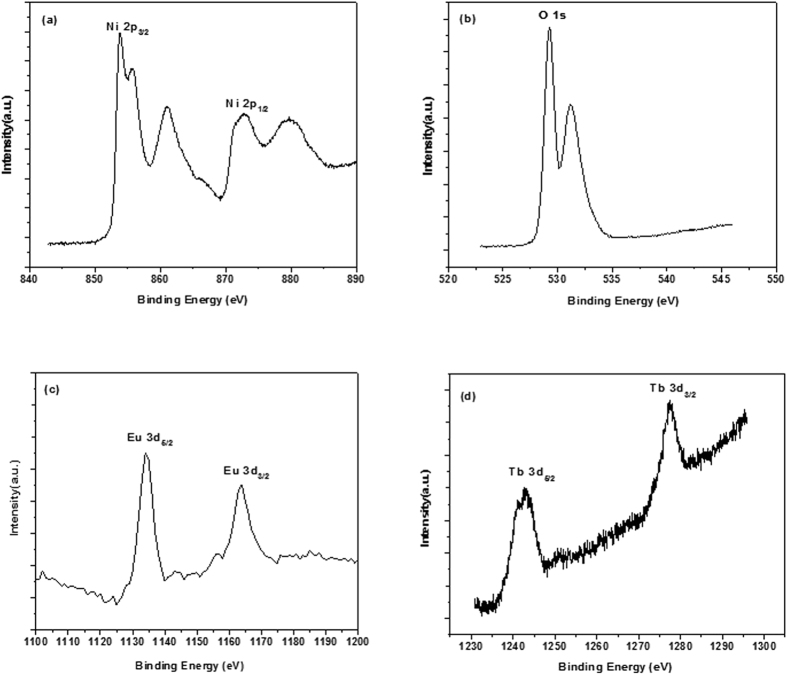
XPS spectra of (a) Ni 2p, (b) O 1s, (c) Eu 3d and (d) Tb 3d for NiO:Eu3+,Tb3+.